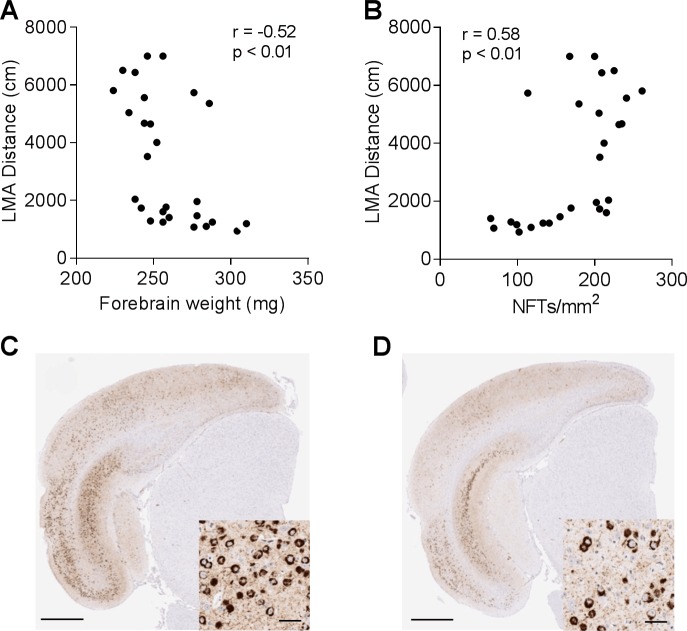
LMA in 5-month-old rTg4510 mice correlates with brain atrophy and NFT pathology.(A), Negative correlation between LMA and forebrain weight (r = -0.52, p<0.01, n = 27). (B), Positive correlation between LMA and NFT pathology in entorhinal cortex (r = 0.58, p<0.01, n = 27). (C–D), Representative images of NFT pathology in entorhinal cortex of rTg4510 mice with LMA distance > 2000 cm (C) and < 2000 cm (D). Insets, higher magnification images of NFT bearing neurons in entorhinal cortex (Scale bar, 800 μm; 20 μm in inset).